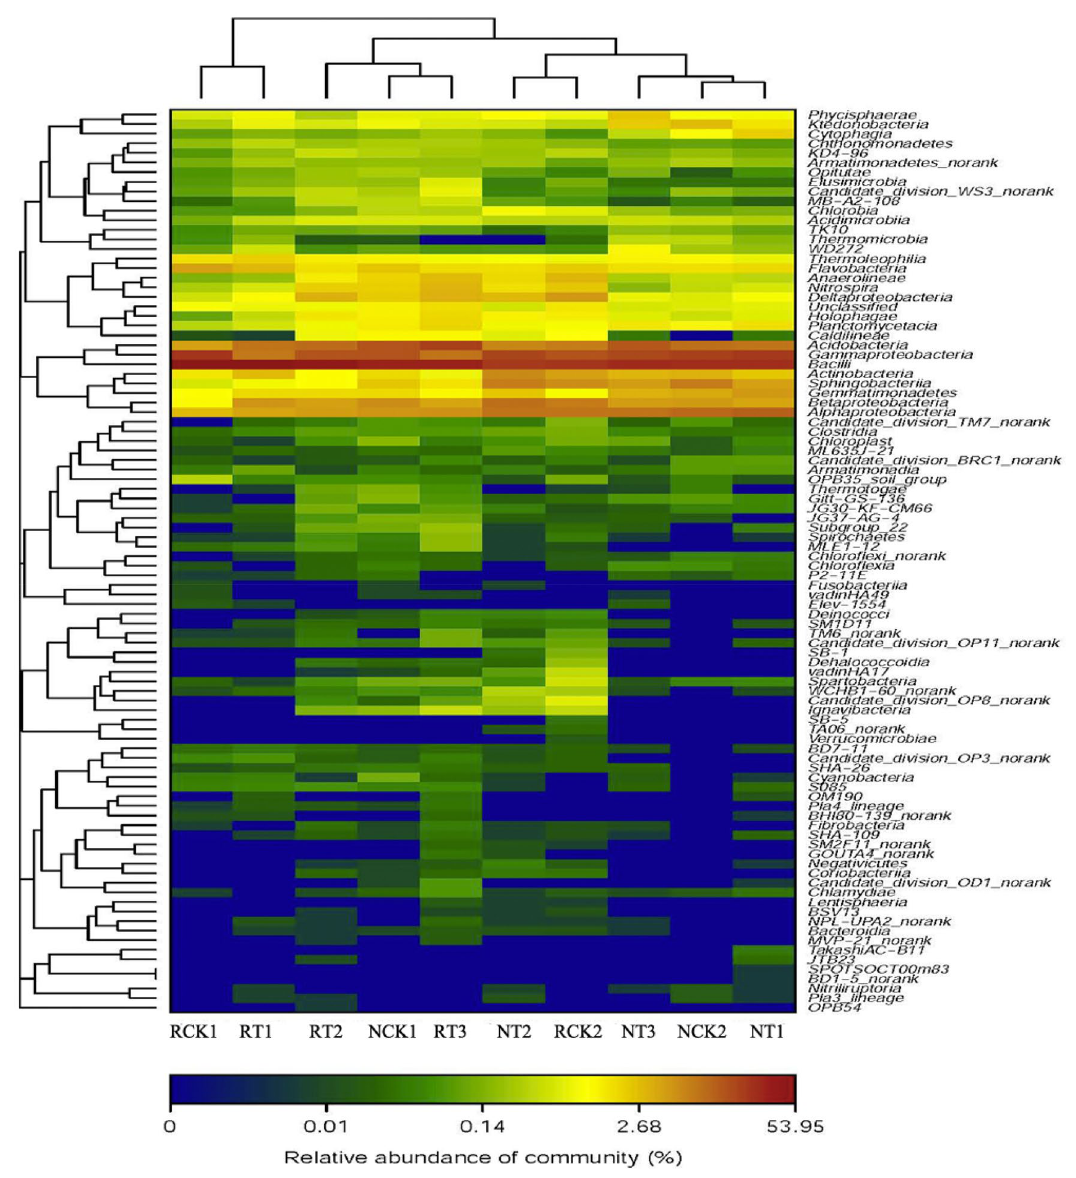
Figure 6. Species abundance clustering diagram of soil bacteria in different treatments at the genus level. RCK1: R-soil in CK1; RCK2: R-soil in CK2; RT1: R-soil in T1; RT2: R-soil in T2; RT3: R-soil in T3; NCK1: N-soil in CK1; NCK2: N-soil in CK2; NT1: N-soil in T1; NT2: N-soil in T2; NT3: N-soil in